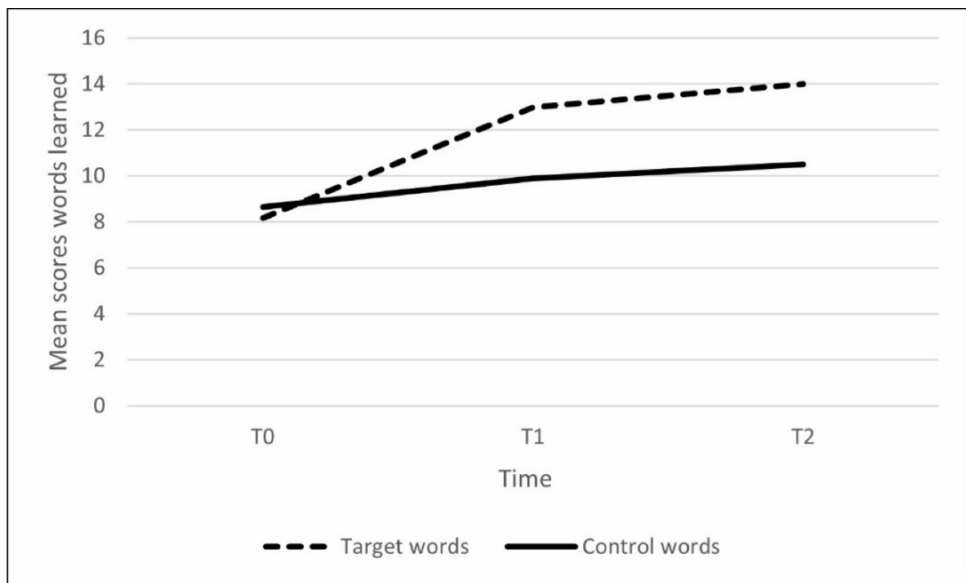
Figure 3. Target words and control words at baseline (T0), directly post-intervention (T1), and at retention measurement